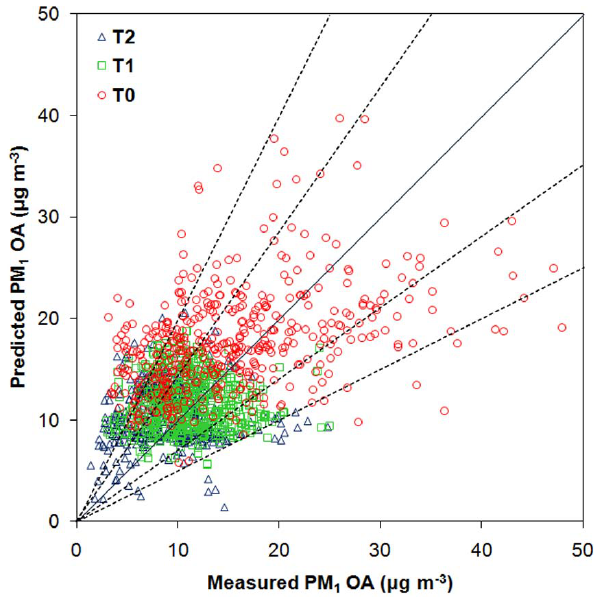
Fig. 5. Comparison of predicted hourly average OA concentrations against observational data from T0, T1, and T2 measurement sites. Also shown are the 1:1, ± 30%, and ± 50%